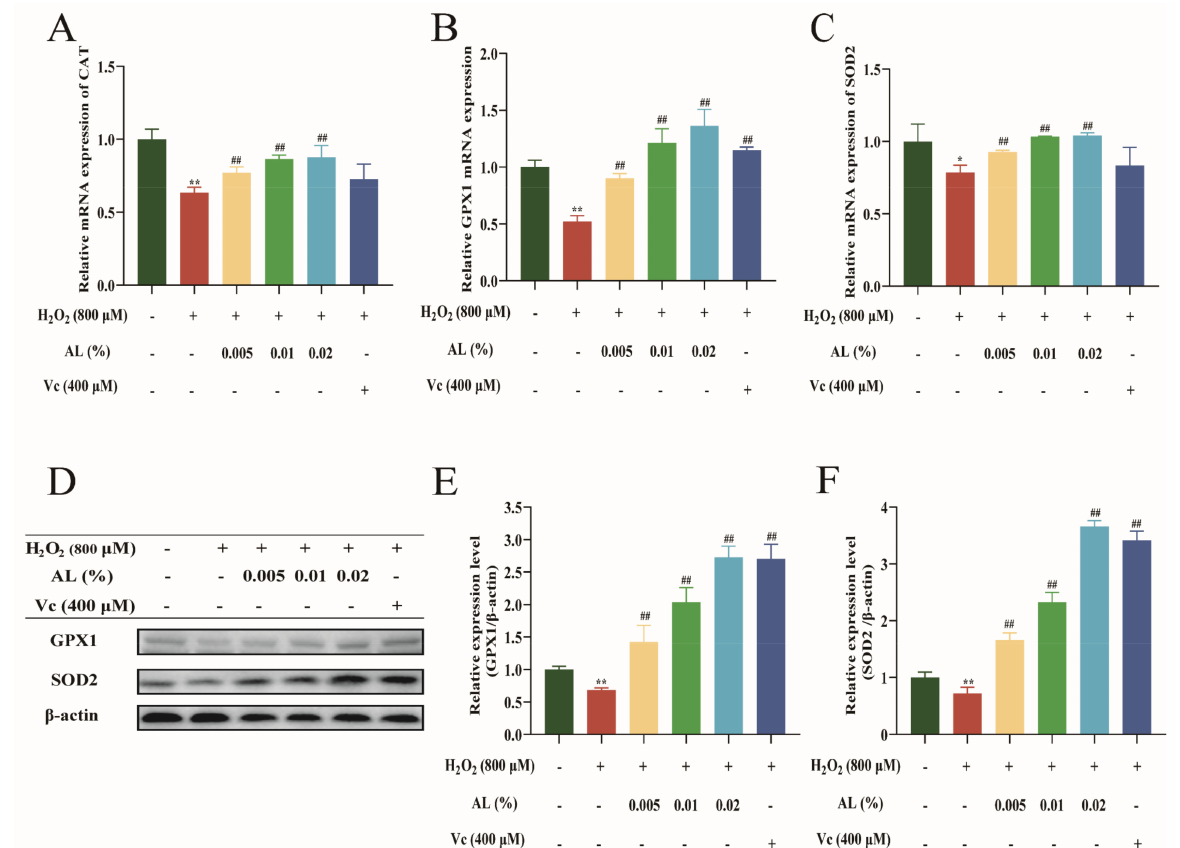
Figure 6. AL stimulated the expression of antioxidases in HaCaT cells. Relative mRNA expressions of CAT ( A ), GPX1 ( B ), and SOD2 ( C ) were detected in HaCaT cells via RT − qPCR. ( D ) Protein bands of GPX1 and SOD2 using Western blotting; protein quantification assay of GPX1 ( E ) and SOD2 ( F ) using ImageJ software. Results are expressed as means ± SDs of three independent experiments. ** p < 0.01 compared to the normal group (no treatment); ## p < 0.01 compared with the H 2 O 2 group. One-way ANOVA was used to evaluate